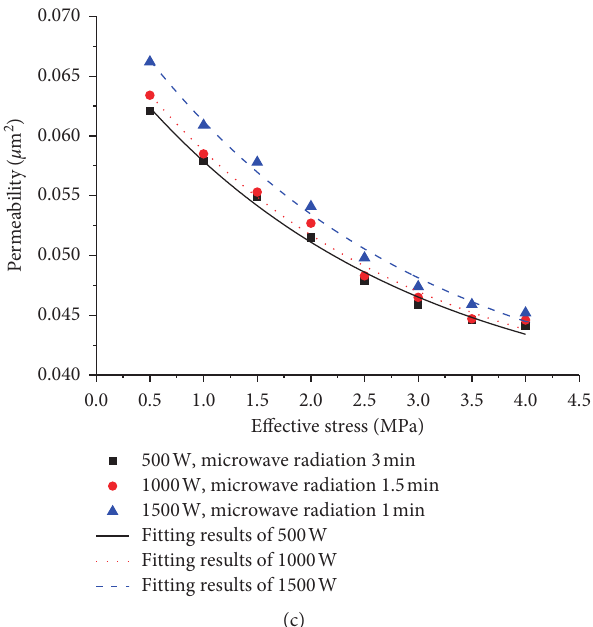
Figure 12: Variation trends of permeability with the same energy input.